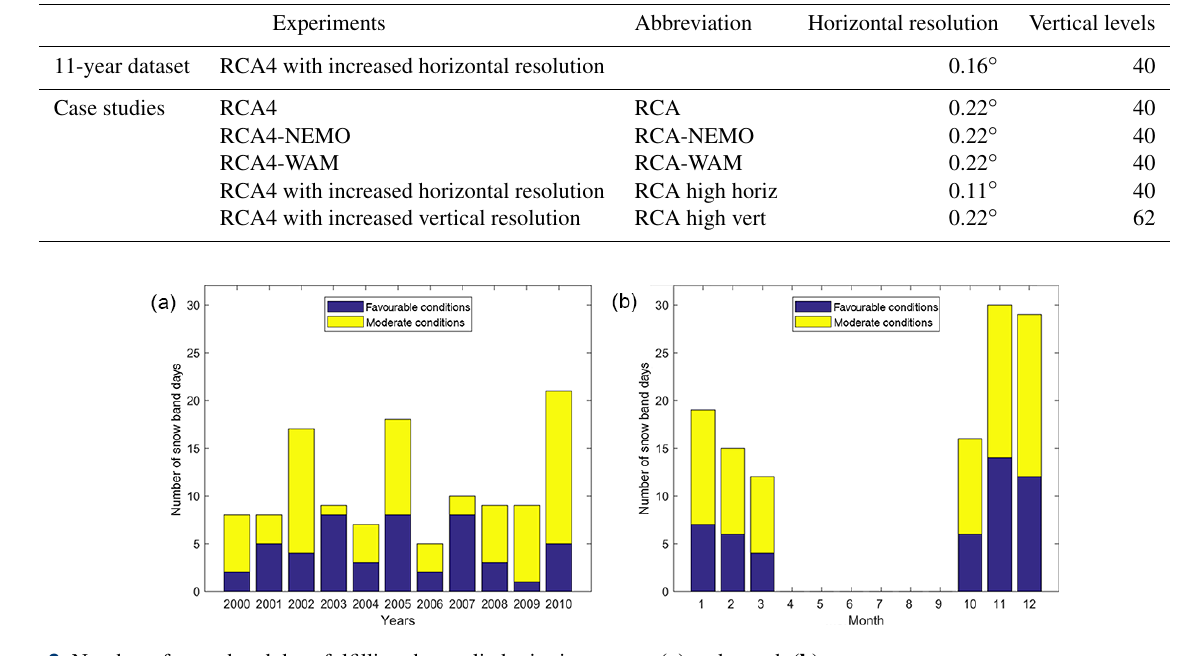
The mean value of the maximum snowfall rate of each day amounts to 0.8 mm h − 1 . Accumulated over the day, the snow- fall varies between 1.5 and 17 mm d − 1 , with a total mean of 5.8 mm d − 1